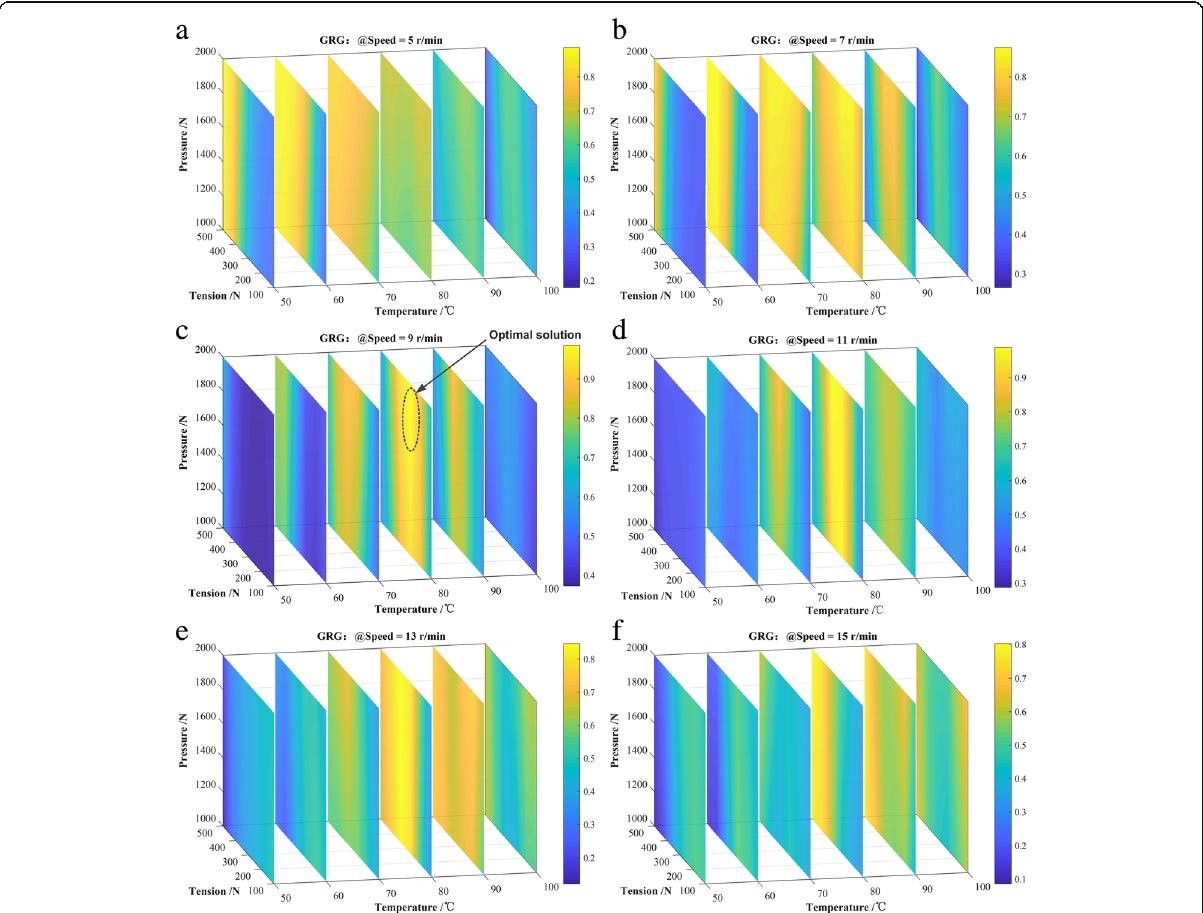
Fig. 6 The slice in 3D view for process parameters influence on the GRG. a Speed=5r/min, parameters influence on GRG. b Speed=7r/min, parameters influence on GRG. c Speed=9r/min, parameters influence on GRG. d Speed=11r/min, parameters influence on GRG. e Speed=13r/min, parameters influence on GRG. f Speed=15r/min, parameters influence on GRG